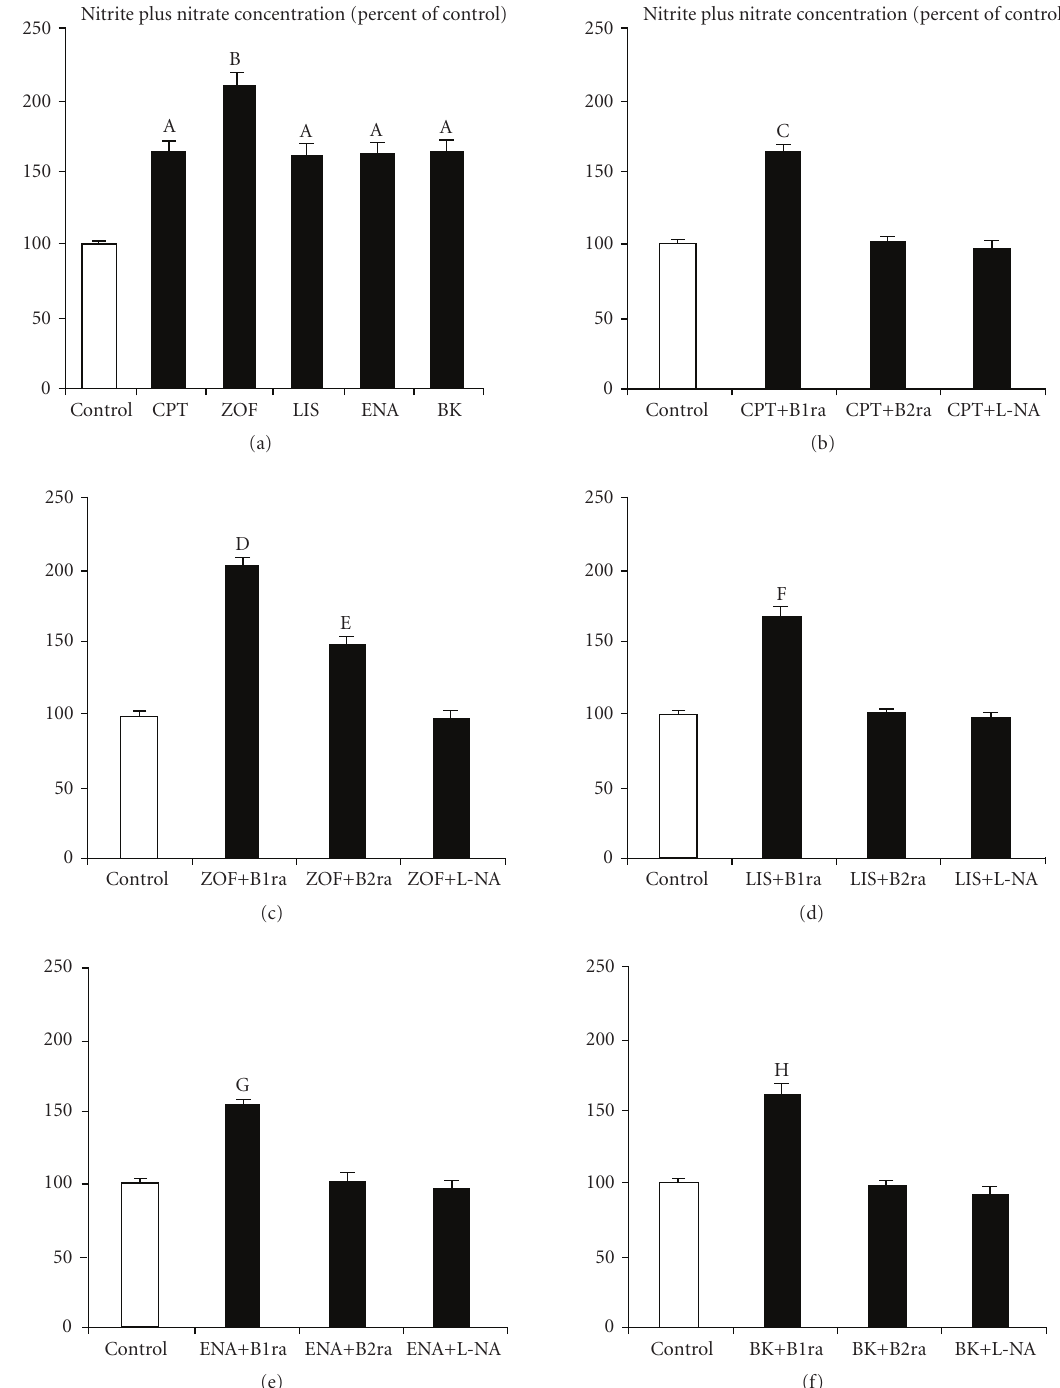
Figure 2: E ff ects of 10 − 8 M captopril (CPT, (a) and (b)), zofenoprilat (ZOF, (a) and (c)), lisinopril (LIS, (a) and (d)), enalaprilat (ENA, (a) and (e)), and bradykinin (BK, (a) and (f)) on nitric oxide production, as evaluated by nitrite plus nitrate concentrations in culture medium (expressed as % of control) by vascular endothelial cells derived from umbilical cord vein after 8 hours of incubation both alone and in the presence of either Des-Arg 9 -[Leu 8 ]-BK, that is, a bradykinin B 1 receptor antagonist (B1ra, 10 − 6 M), or D-Arg-[Hyp 3 ,Thi 5,8 ,D-phe 7 ]-BK, that is, a bradykinin B 1 receptor antagonist (B2ra, 10 − 6 M), or the NO synthase competitive inhibitor N ω -nitro-L-arginine methyl ester (L-NA, 3 × 10 − 3 M). (A) P < . 0001 versus control; (B) P < . 02 or less versus CPT, LIS, ENA, and BK and P < . 0001 versus control; (C) P < . 0003 or less versus control, CPT+B2ra and CPT+L-NA; (D) P < . 0001 versus control and ZOF+L-NA and P < . 003 versus ZOF+B2ra; (E) P < . 003 versus control and ZOF+L-NA; (F) P < . 0004 or less versus control, LIS+B2ra and LIS+L-NA; (G) P < . 0006 or less versus control, ENA+B2ra and ENA+L-NA; (H) P < . 0001 versus control, BK+B2ra and